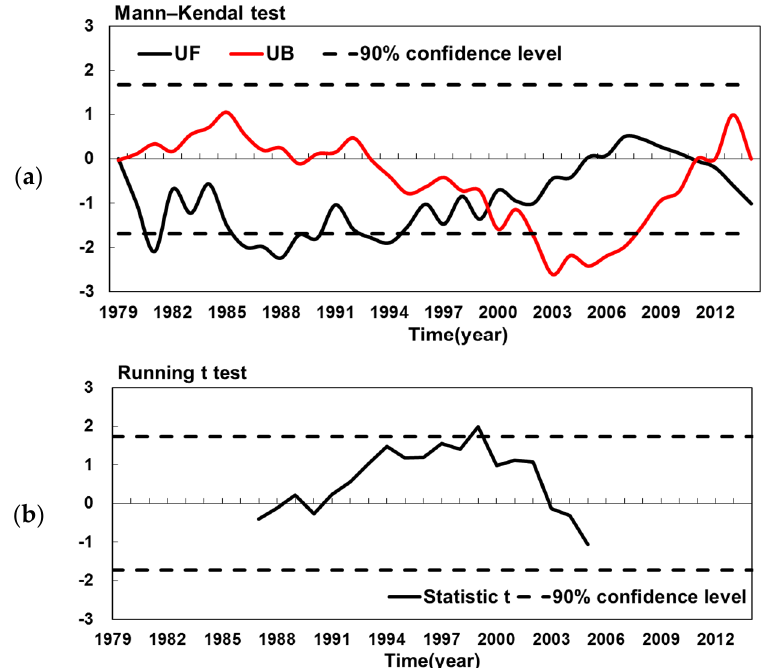
Figure 3. Mann − Kendall ( a ) and running t ( b ) tests for the time series of the summer RA − ERE over the HRB during the period 1979 − 2014. The two black dashed lines indicate the 90% confidence level of the two tests. In ( a ), the black line denotes the sequential statistical curve UF, and the red line denotes the re-verse statistical curve UB. The black line in ( b ) denotes the sequential statistical curve t.